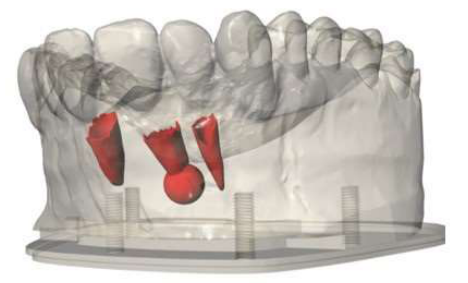
Figure 4. Meshes of the granuloma on tooth 11 and the periodontal ligament on teeth 11, 12 and 21 which will be printed in soft support material (red).